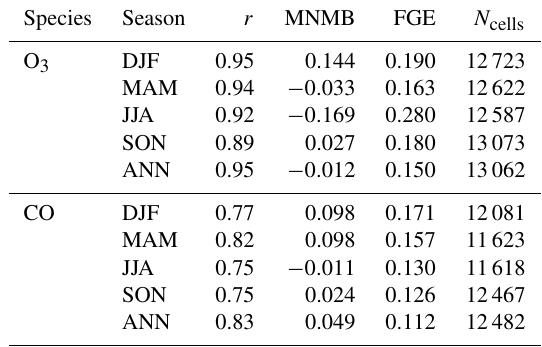
Table 1. Seasonal and annual metrics synthesizing the assessment of the simulated O 3 and CO climatologies by IAGOS-DM, gather- ing all the vertical grid levels as in Fig. 6. From left to right: Pear- son’s correlation coefficient ( r ), modified normalized mean bias (MNMB), fractional gross error (FGE) and the sample size ( N cells